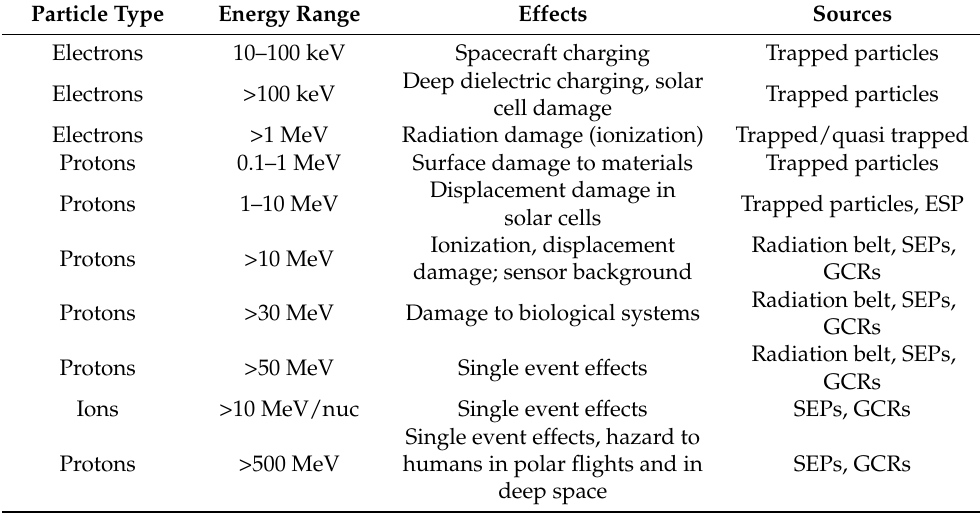
Table 3. Particles in various energy ranges, their sources, and their effects.